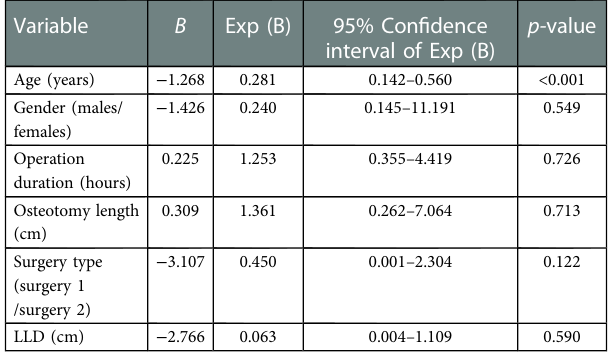
TABLE 4 Analysis of risk factors of femoral overgrowth ≥ 1 cm after DDH